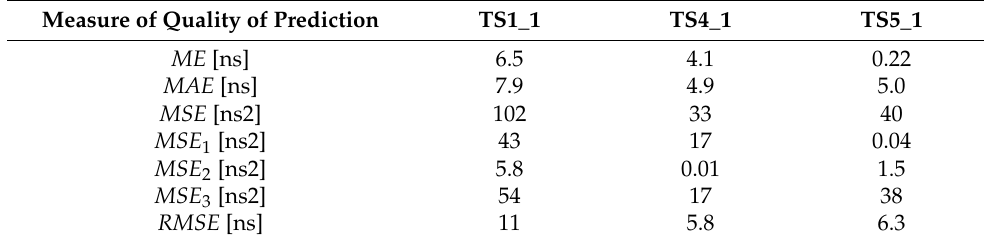
Table 2. Obtained values of selected quality prediction measures for the TS1_1, TS4_1, and TS5_1. Measure of Quality of Prediction